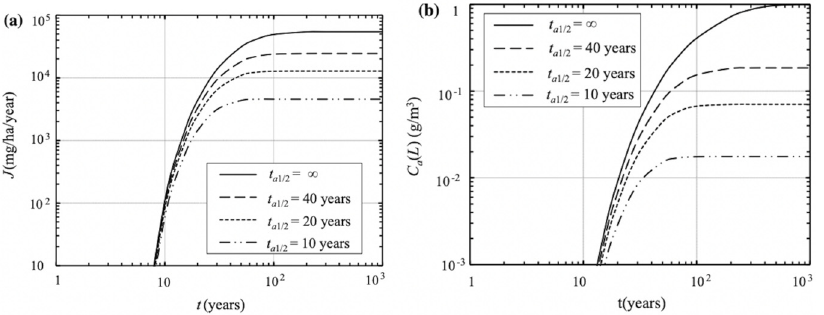
Figure 5. Effect of degradation on pollutant flux ( a ) and concentration ( b ) at the bottom of GM/GCL/AL liners. Reprinted with permission from Ref. [93], Copyright 2016 Springer.